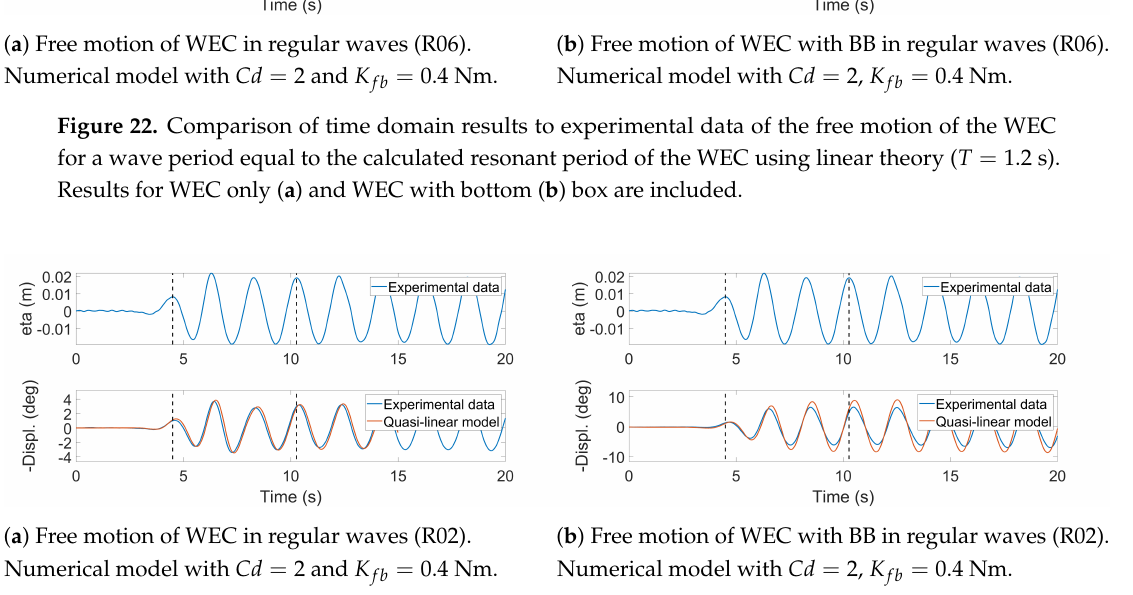
Figure 23. Comparison of time domain results to experimental data of the free motion of the WEC for a wave period equal to the calculated resonant period of the WEC when there is the bottom box using linear theory ( T = 2 s). Results for WEC only ( a ) and WEC with bottom ( b ) box are included.